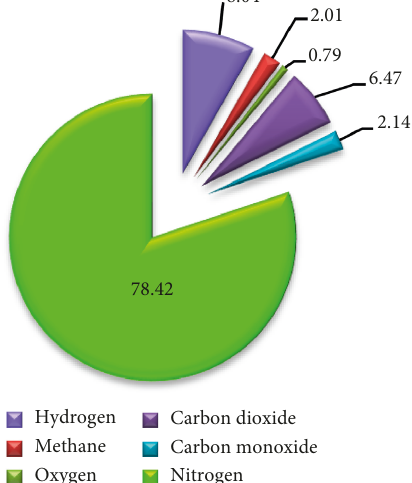
Figure 6: Noncondensable gas